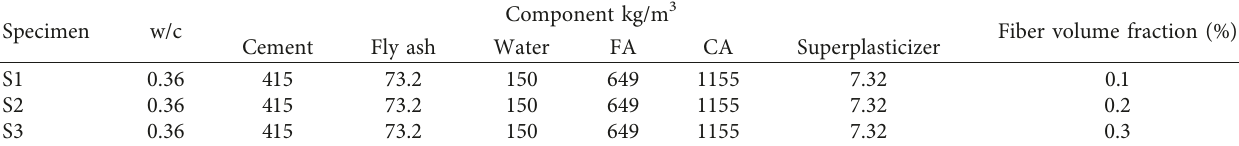
Table 1: Concrete mixture proportions.